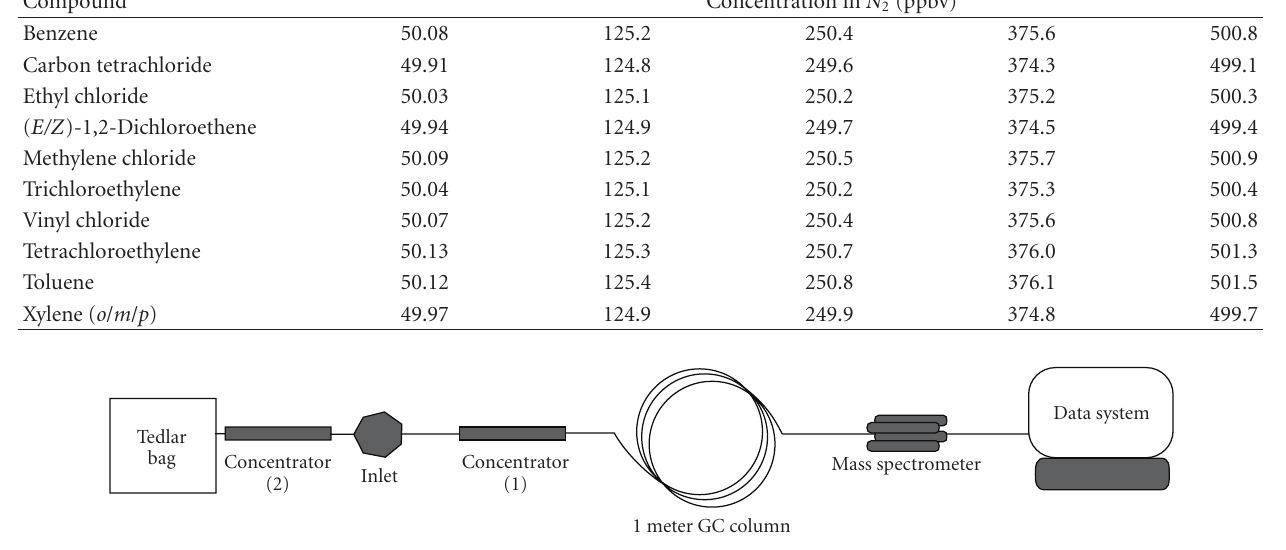
Figure 3: Configuration used for breakthrough study.